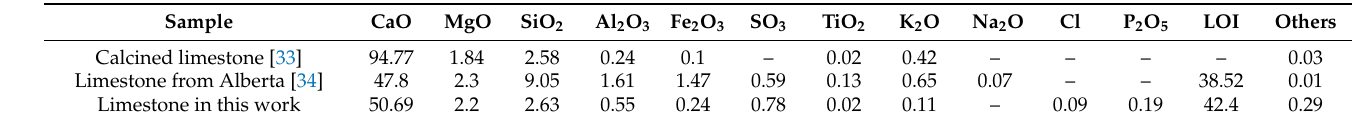
Table 1. Chemical composition of limestone